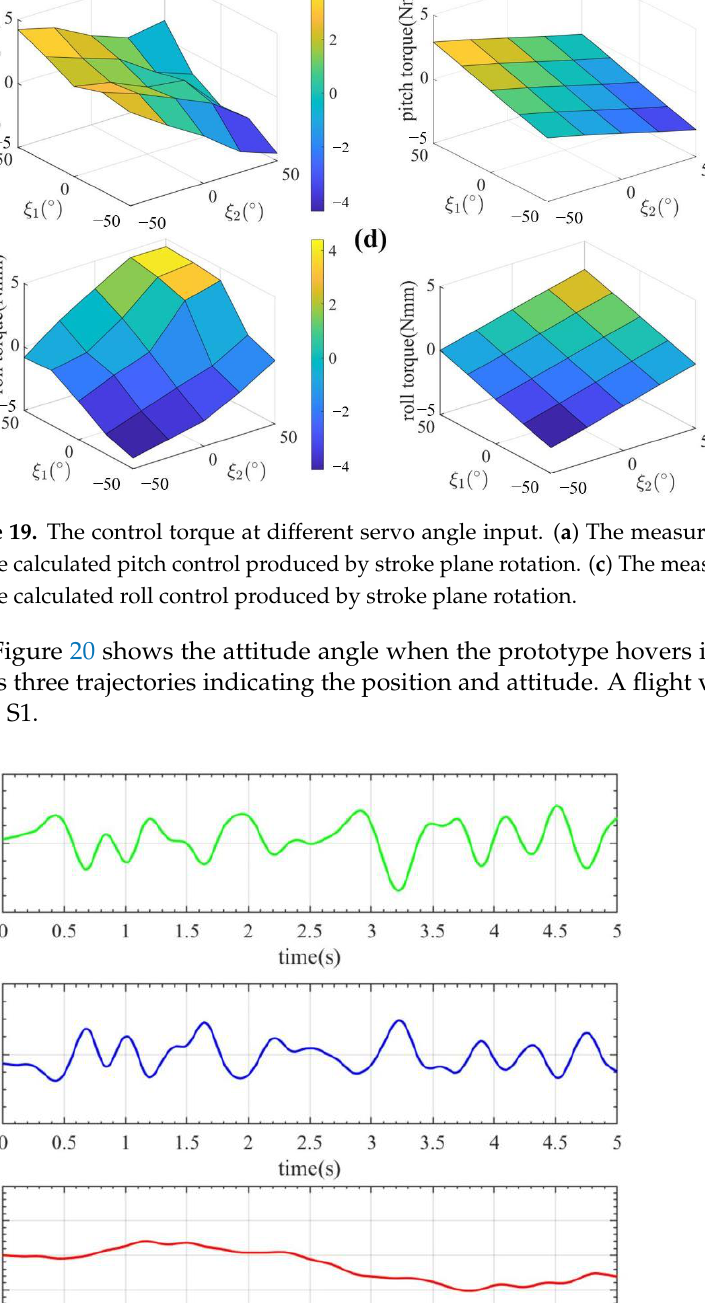
Figure 21. Three trajectories of the prototype in flight test. The line indicates the position and the arrow indicates the attitude. The results showed that the prototype could maintain its attitude stability during flight with the cooperation of the controller and the control mechanism, had an oscillation of roll and pitch angle of no more than 10°, the yaw angle remained stable, and turned back to zero in time. The results verified the effectiveness of the adopted parallel control mechanism and the corresponding control algorithm. 5. Conclusions This paper designed an insect-like FMAV with a string-based flapping wing mecha- nism and a parallel control mechanism. Compared to previous research, a method to op- timize the pulley profile was proposed for a string-based mechanism that helped reduce the string deformation and impact. A parallel mechanism that controlled the stroke plane was designed and the positive and negative kinematic solution of the mechanism was derived. A set of parameters was selected to provide the mechanism with a maximum